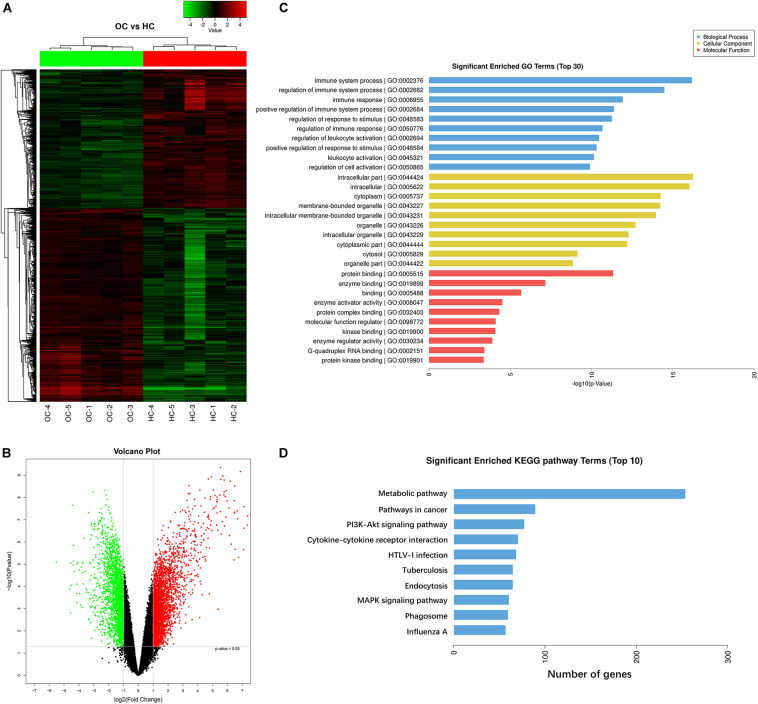
Transcriptome analysis suggests metabolic pathways are closely associated with peripheral CD4+ T cells of OC patients. (A,B) Gene expression profiles of CD4+ T cells derived from peripheral blood of ovarian cancer patients and healthy controls. Hierarchical clustering analysis of 5,175 mRNAs that are differentially expressed in peripheral blood CD4+ T cells from five ovarian cancer patients (OC) and peripheral blood CD4+ T cells from five healthy controls (HC), and 3,014 were up-regulated and 2,161 were down-regulated. Each column represents an individual sample and each row represents a specific gene. The threshold of significance was defined by P < 0.05 with Student t-test and the false discovery rate, log2 fold change (>2 or <–2), were considered as up-regulated and down-regulated genes, respectively. The expression values are shown in shades of red and green. Green means gene expressed at lower levels; red means gene expressed at higher levels. (C,D) Pathway analysis showing the significant pathways of the differentially expressed genes (P < 0.05 with Student t-test), metabolic pathways were the most significant. Gene ontology (GO) analysis indicated that the most significant enriched GO Terms on biological process among the top 10 enriched pathways were the immune system process. Kyoto Encyclopedia of Genes and Genomes (KEGG) analysis identified 296 enriched pathways, and metabolic pathways were the most significantly represented among the top 10 enriched pathways.